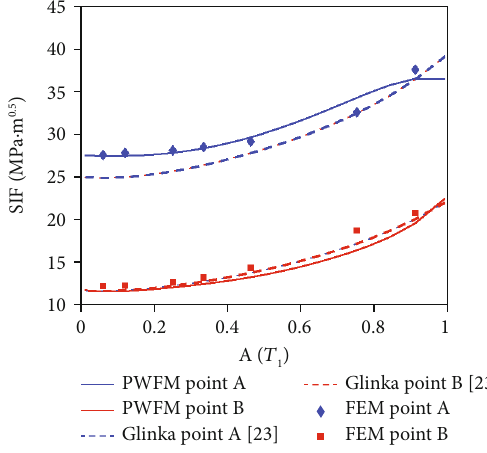
(b) Comparison of SIF results when cracks under stress distribution Equation (18) Figure 5: Comparison of SIF results based on universal weight function method, point weight function method, and fi nite element method when cracks under univariant stress distributions ( L 1 ⟶ ∞ , H 1 ⟶ ∞